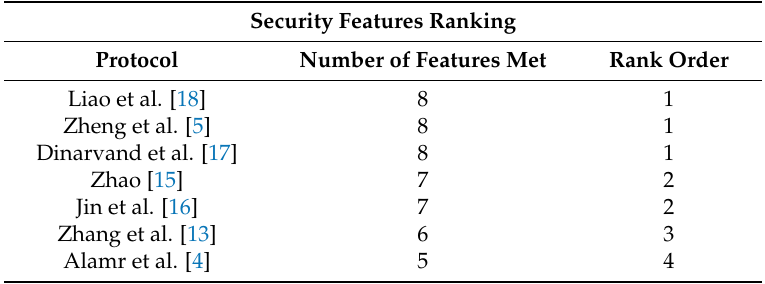
Table 12. Ranking based on the number of security features each protocol provides.